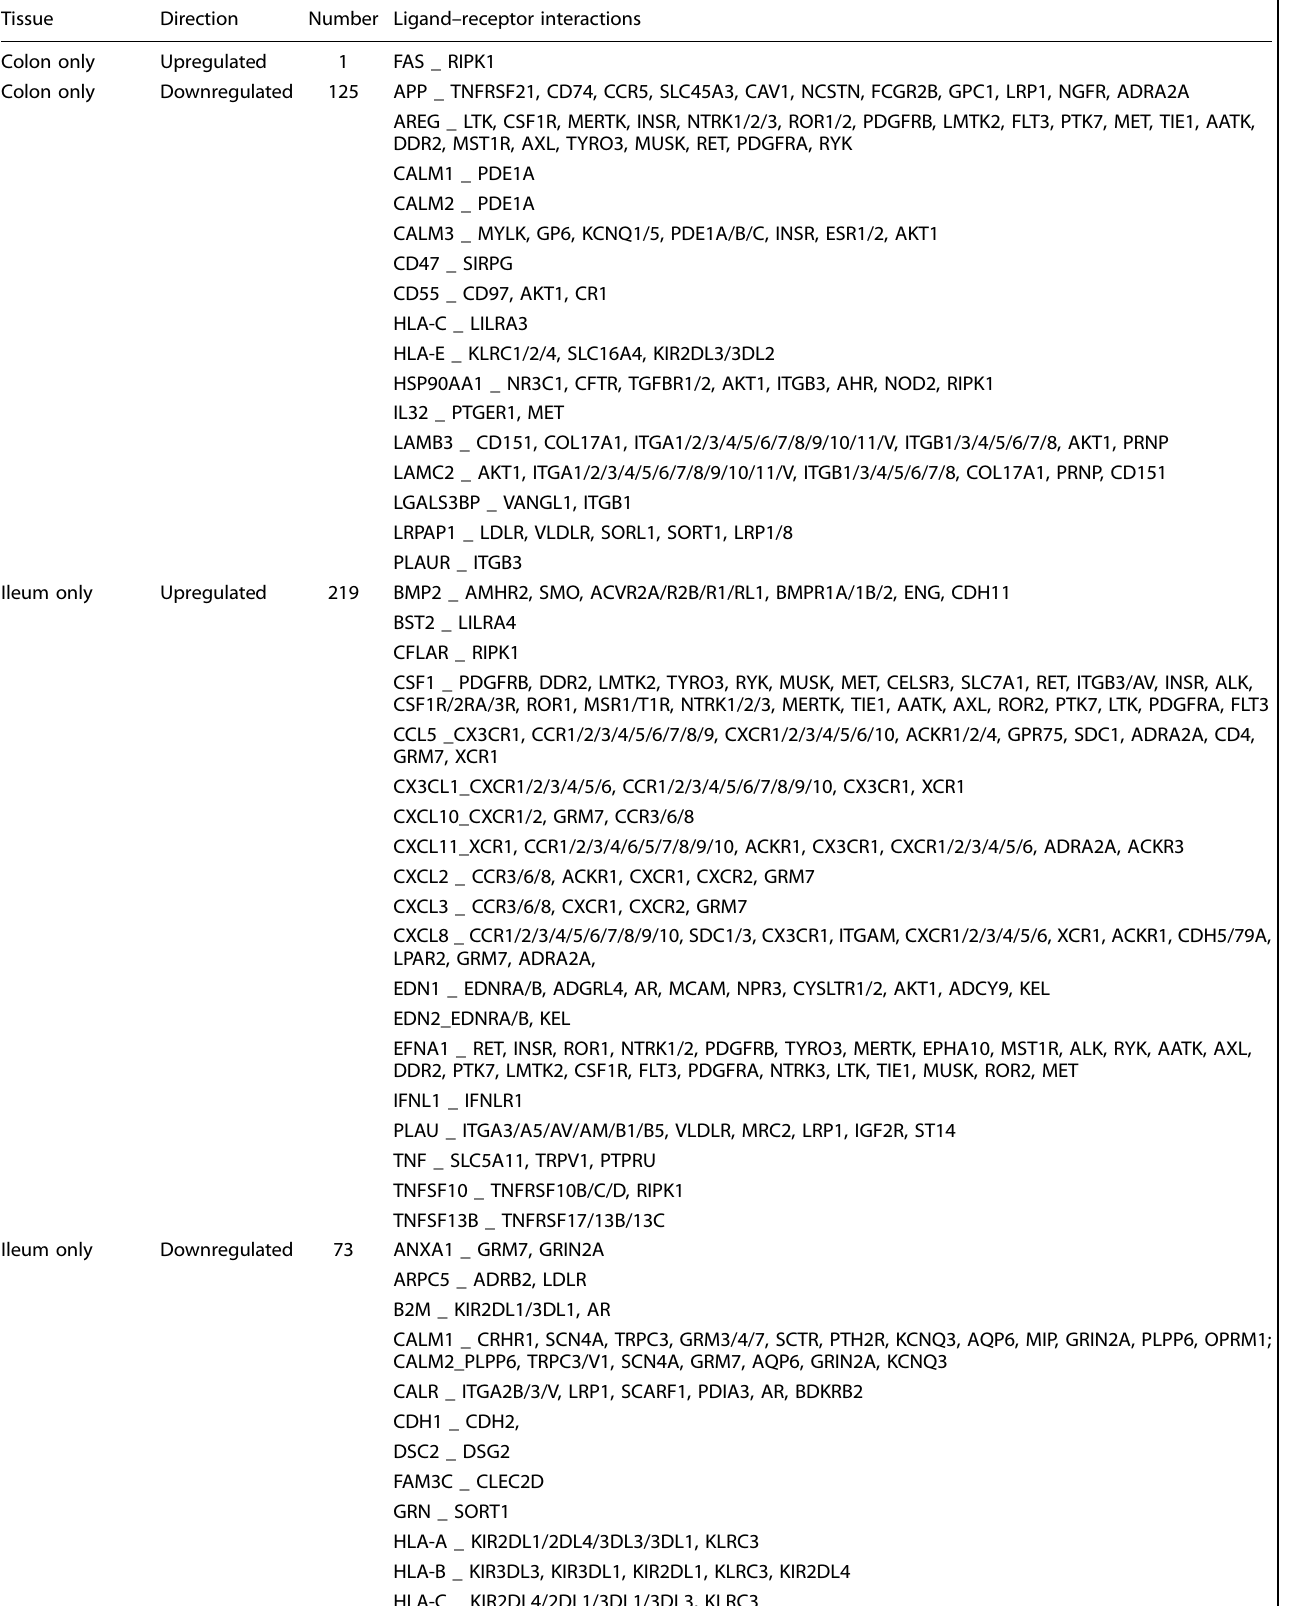
Table 3. Ligand – receptors in intercellular interactions in the colon and ileum. Tissue